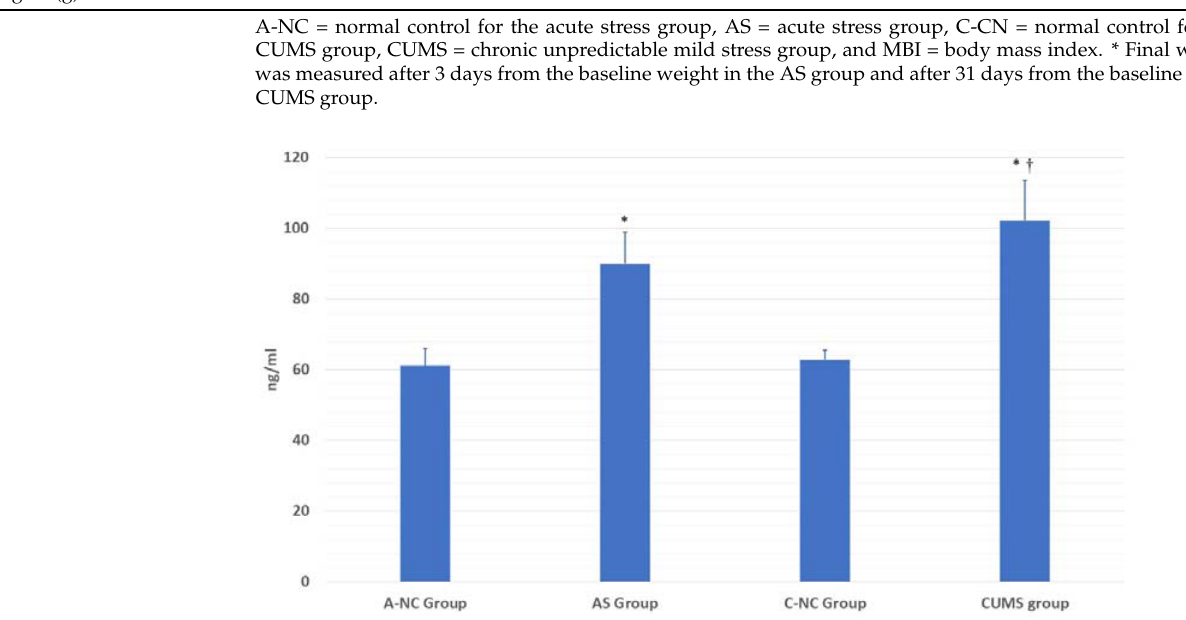
Figure 2. Corticosterone plasma levels after the AS and CUMS versus control. The asterisk represents statistical differences versus control ( p < 0.05). † denotes the significant difference between CUMS and AS groups ( p < 0.01). Table 3. Indirect calorimetry parameters of all studied